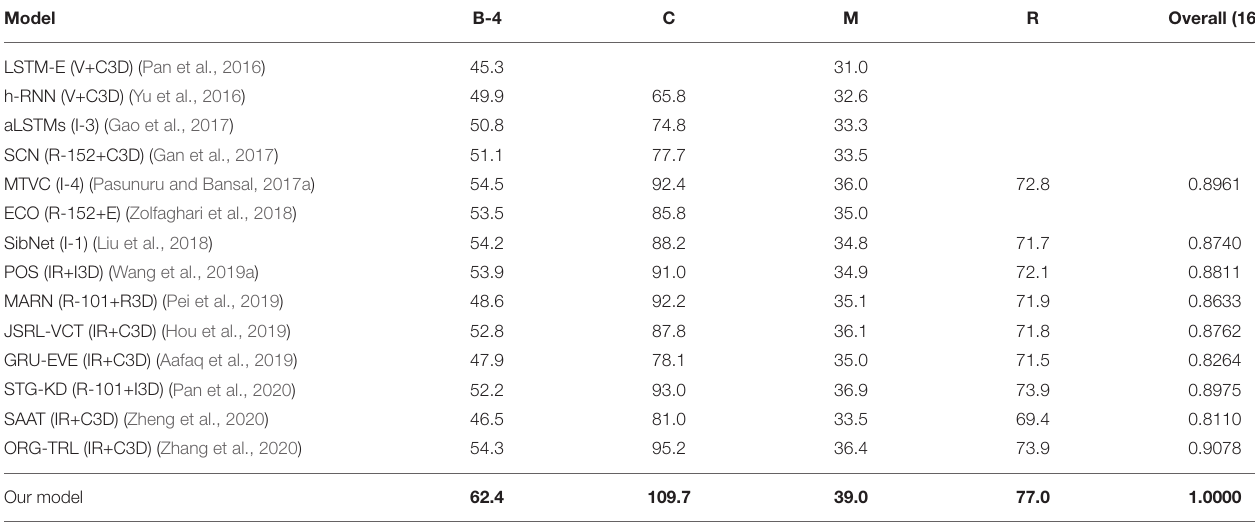
TABLE 1 | Result comparison with existing models on the YouTube2Text dataset.